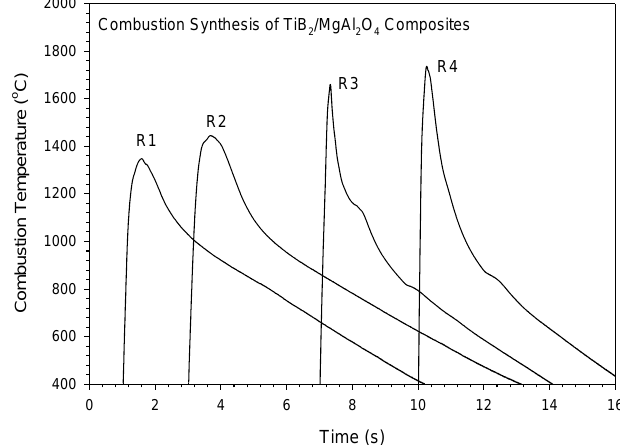
Figure 3. Typical combustion temperature profiles measured from Equation (1)–(4) for the synthesis of 3TiB 2 –MgAl 2 O 4